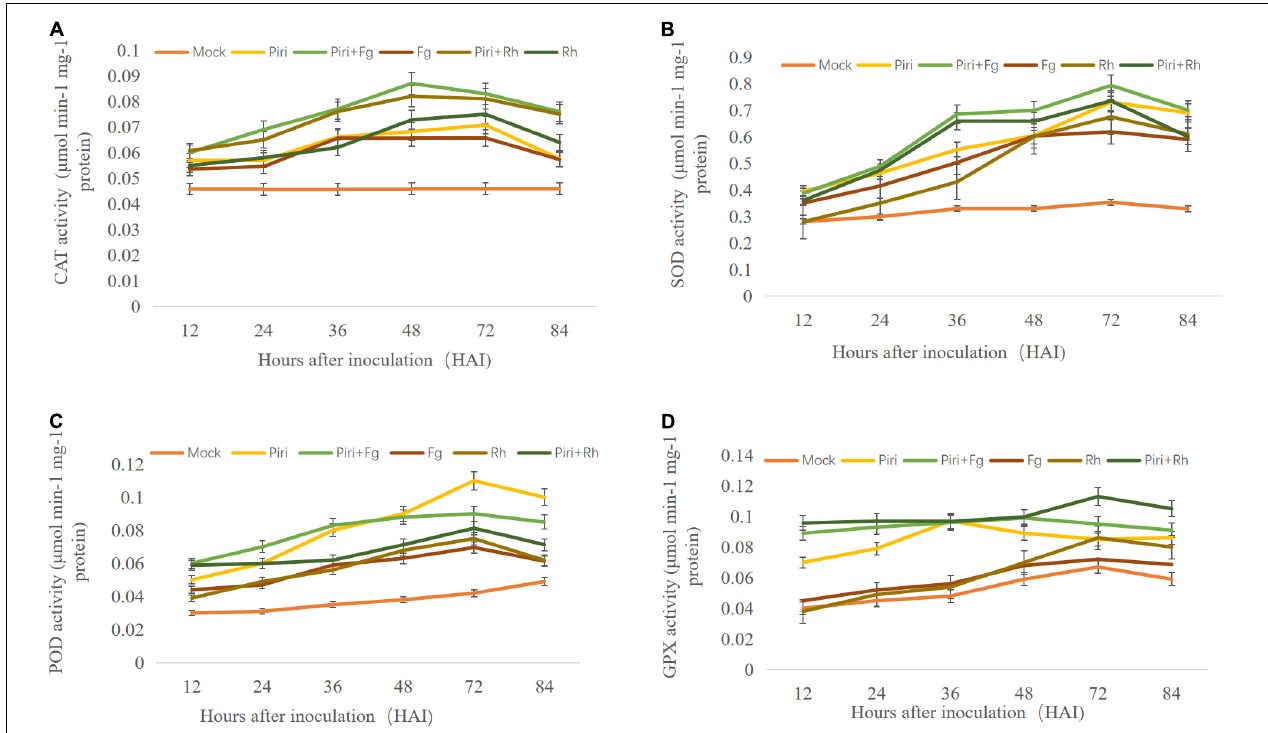
FIGURE 6 | Determination of antioxidant enzymes activity in wheat seedlings with various treatments at different time points after different fungi inoculation. (A) Catalase (CAT) activity; (B) superoxide dismutase (SOD) activity; (C) peroxidase (POD) activity; (D) Guaiacol peroxidase (GPX) activity. Piri, P. indica ; Fg, F. graminearum ; Rh, R. cerealis ; Piri + Fg, P. indica + F. graminearum ; Piri + Rh, P. indica + R. cerealis.